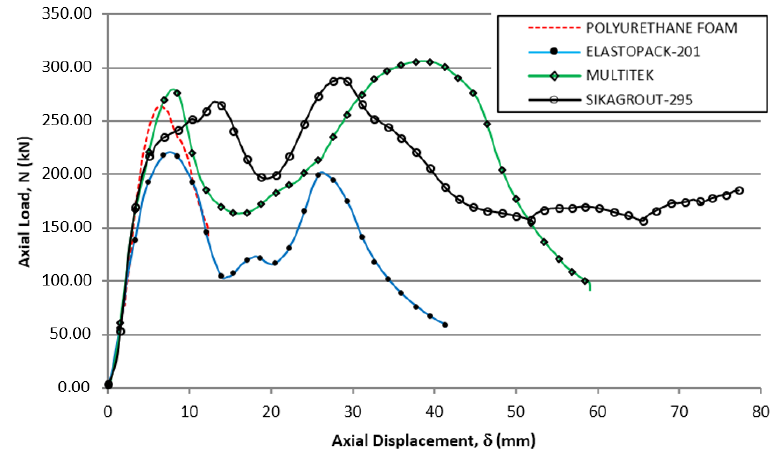
Figure 5. Hybrid tube load-displacement curves in compression tests and single steel tubes used as inner tubes in the hybrid element.